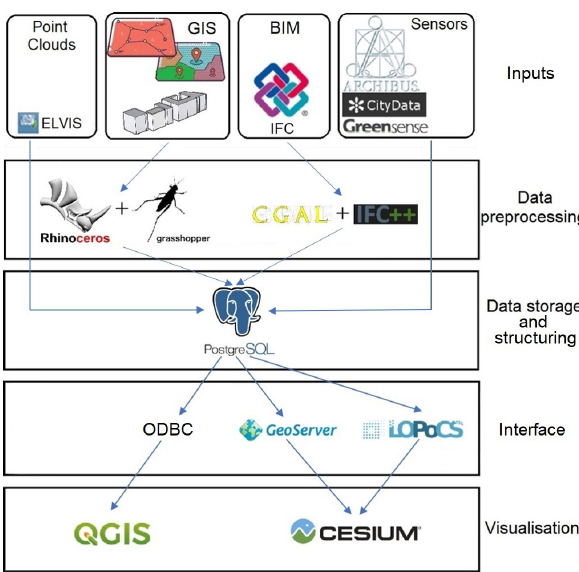
Figure 2. System architecture for this